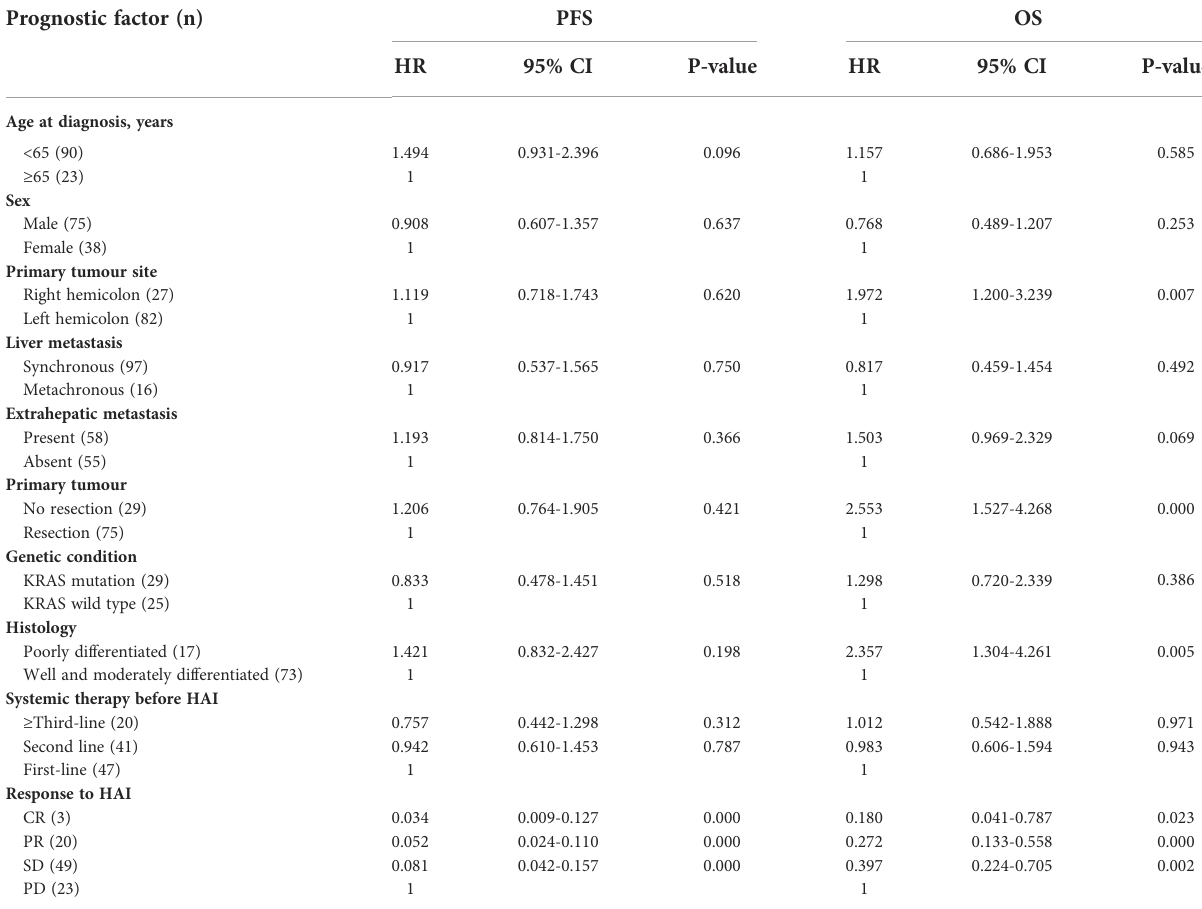
TABLE 3 Cox univariate analyses of prognostic factors for survival.